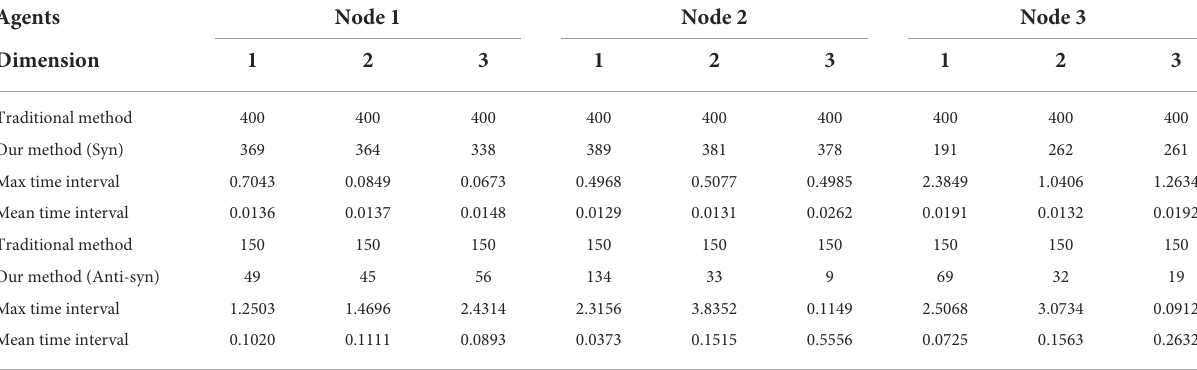
TABLE 2 Performance comparison of periodic sampling control and proposed scheme. Agents Node 1